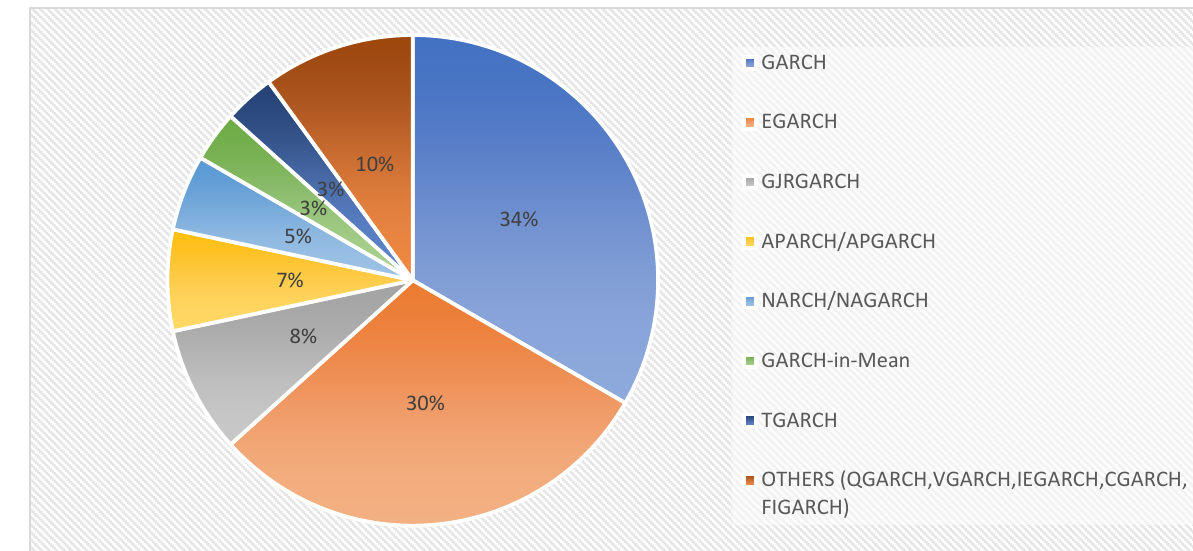
Figure 9. Frequency of GARCH models used. Source: Authors’ calculation.